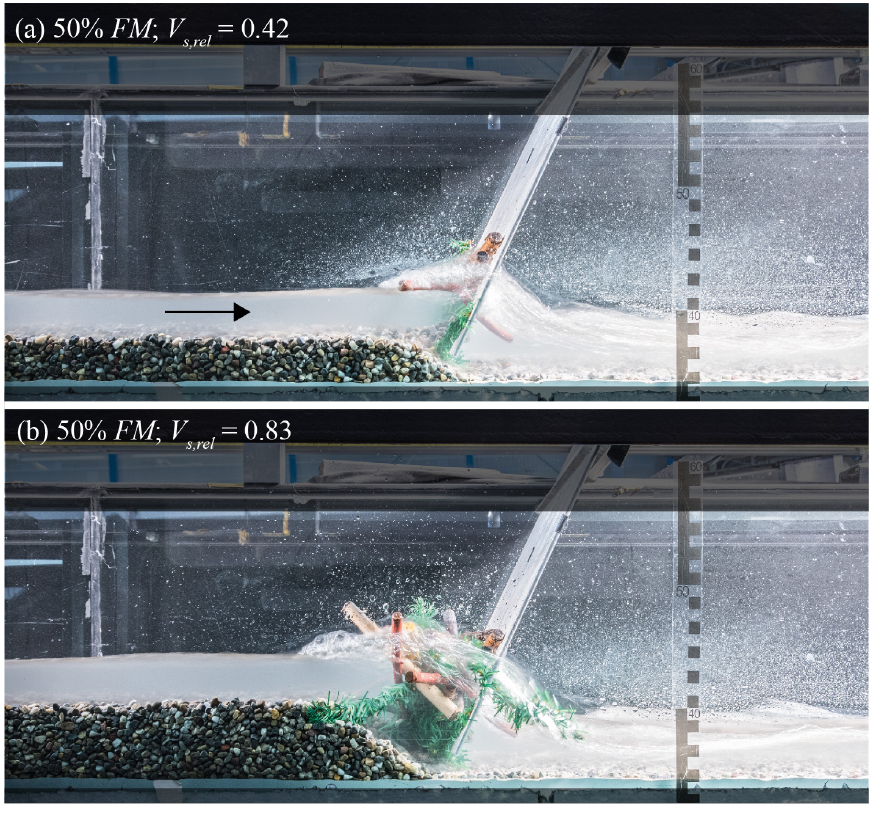
Figure 8. LW accumulation and bedload deposition at the inclined bar screen for test V11 with 50% FM and increasing V s , rel : ( a ) V s , rel = 0.42 and ( b ) V s , rel = 0.83 (adapted from the work in [33]).